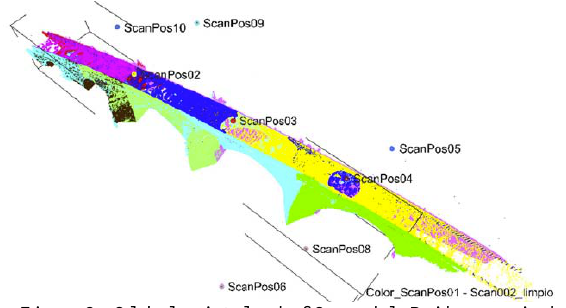
Figure 1.: 3D model of Cernadela Bridge obtained by photogrammetry and camera positions.